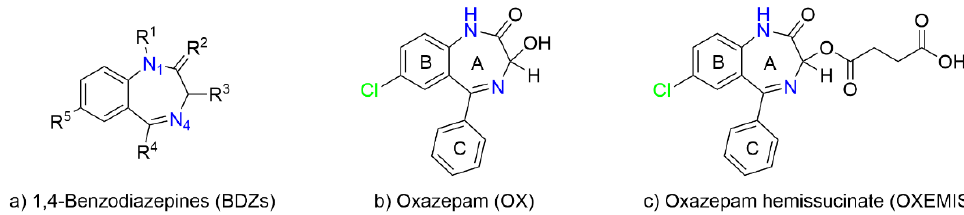
Figure 1. Chemical structures of ( a ) Diazepam ( Valium ): R 1 =CH 3 , R 2 =O, R 3 =H, R 4 =phenyl, R 5 =Cl; Alprazolam ( Xanax ): R 1 =CH(CH 3 )=N-N=R 2 , R 3 =H, R 4 =phenyl, R 5 =Cl; Flurazepam ( Dolmane ): R 1 =(CH 2 ) 2 N(Et) 2 , R 2 =O, R 3 =H, R 4 =2-fluorophenyl, R 5 =Cl; Lorazepam ( Ativan ): R 1 =H, R 2 =O, R 3 =OH, R 4 =2-chlorophenyl, R 5 =Cl; Clonazepam ( Klonopin ): R 1 =H, R 2 =O, R 3 =H, R 4 =2-chlorophenyl, R 5 =NO 2 . ( b ) Oxazepam ( Serax ), and ( c ) Oxazepam succinate half-ester (hemisuccinate).